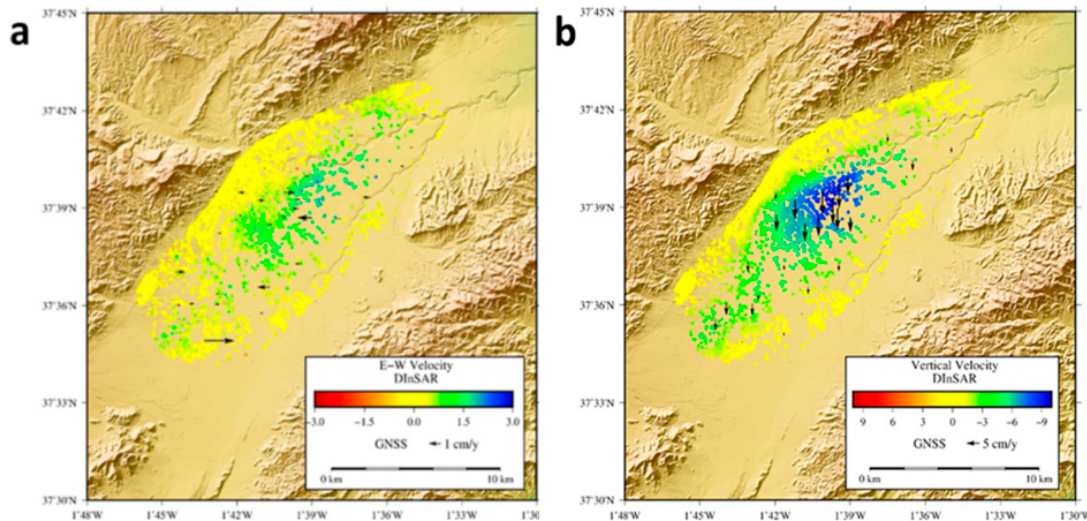
Figure 24. East-West and Vertical displacements obtained by A-DInSAR. ( a ) Horizontal (East-West) and ( b ) vertical (Up-Down) displacement rates estimations obtained by decomposition of the LOS detected velocity using ascending and descending orbits. GNSS displacements are also plotted with arrows to compare. Results are shown for the period November 2015–February 2017. Modified from [5]. The comparison of GNSS and A-DInSAR results allows to estimate the error of the A-DInSAR processing, relative to GNSS, as ~0.7–1 cm